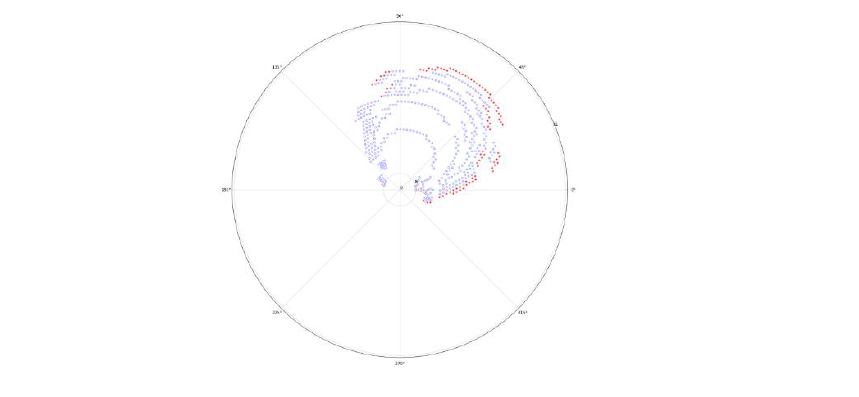
Fig.8. An event display of a multi-turn track after prediction by U-net network in a polar coordinate. Red dots are the first turn hits predicted as fist turn. Red circles are the first turn hits predicted as non-first turn. Red dots with blue circles are the non-first turn hits mis- identified as first